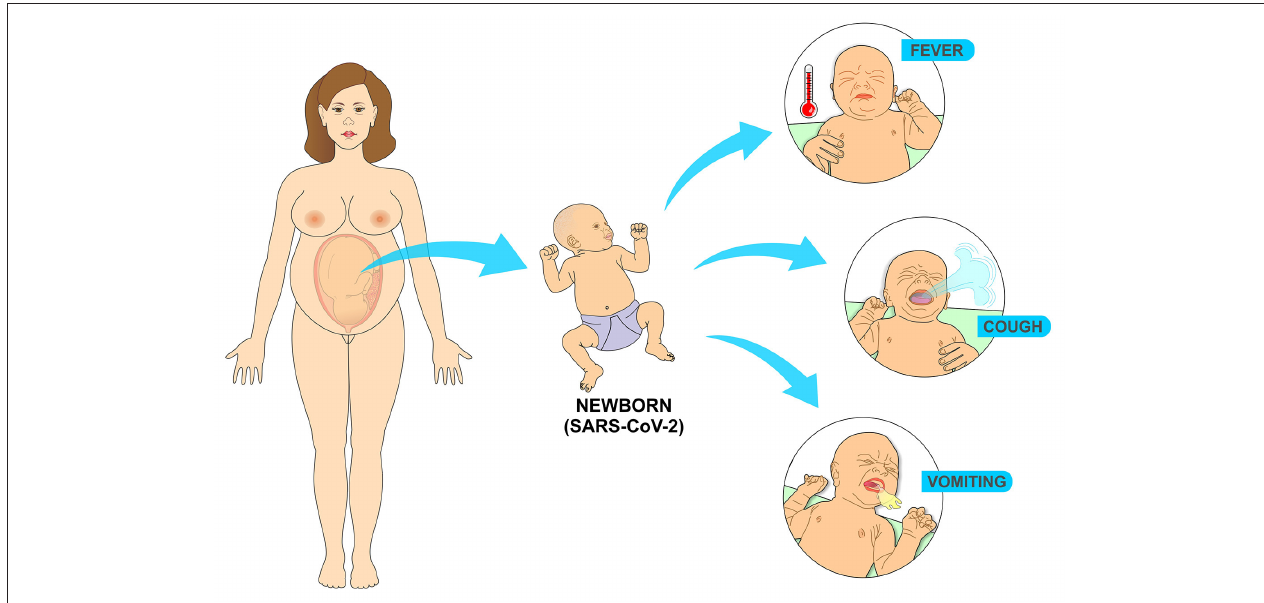
FIGURE 12 | Most common symptoms in the newborn infected with SARS-CoV-2 come from the replication of the virus in the cells of the respiratory tract. Fever results from the immune response to the presence of the virus, while vomiting comes from coughing as a result of the infectious process in the